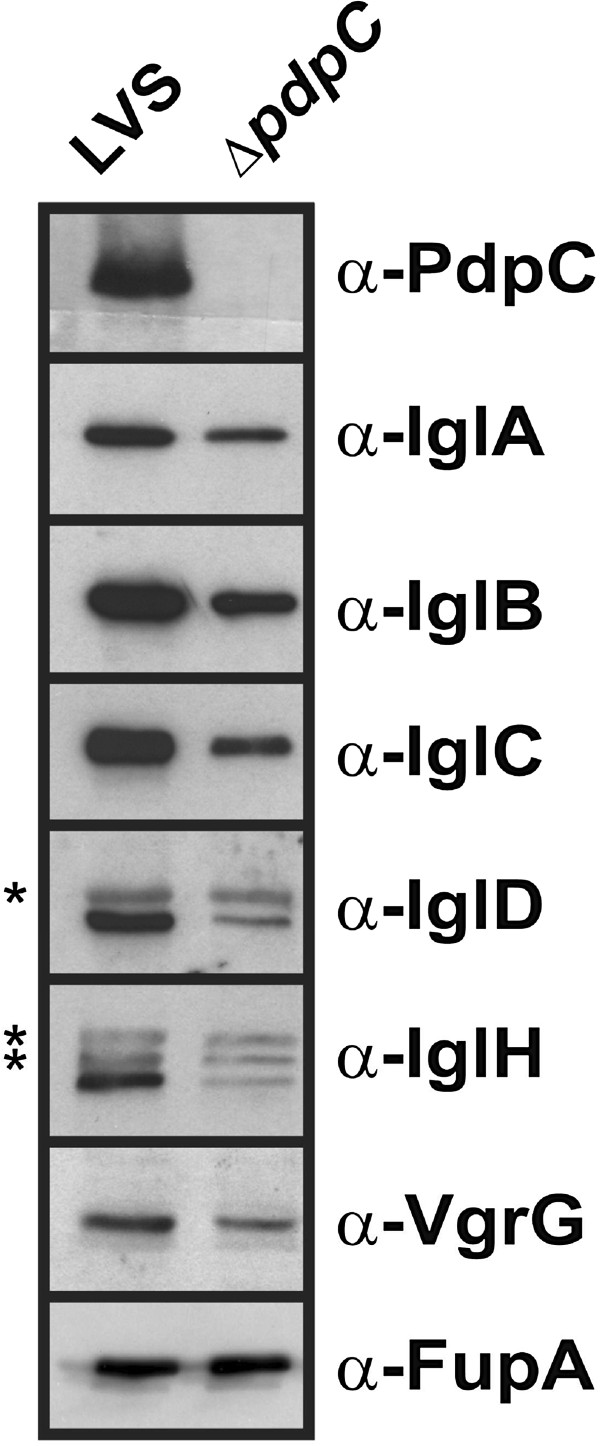
Western blot analysis comparing the levels of FPI proteins between LVS and the ΔpdpC mutant. Whole-cell lysates of Francisella were separated on SDS-PAGE and FPI protein-specific antibodies were used to detect the levels of proteins in the two samples. An antibody against FupA was used as a loading control. Asterisks indicate unspecific bands. The assay was repeated at least three times.